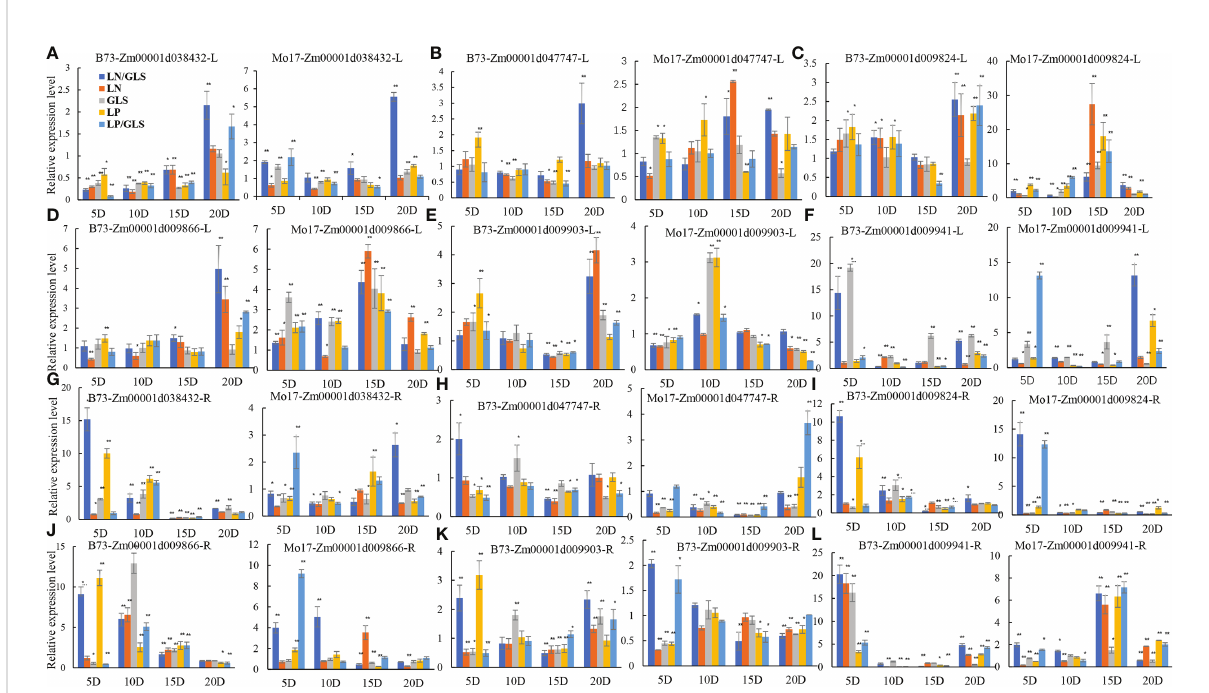
FIGURE 3 Expression patterns of six candidate genes in B73 and Mo17 under different treatments. (A, G) expression of Zm00001d038432 in root and leaf of B73 and Mo17. (B, H) expression of Zm00001d047747 in root and leaf of B73 and Mo17. (C, I) expression of Zm00001d009824 in root and leaf of B73 and Mo17. (D, J) expression of Zm00001d009866 in root and leaf of B73 and Mo17. (E, K) expression of Zm00001d009903 in root and leaf of B73 and Mo17. (F, L) expression of Zm00001d009941 in root and leaf of B73 and Mo17. R, Root; L, Leaf; GLS, Gray spot treatment; LN, Low nitrogen treatment; LP, Low phosphorus treatment; LN/GLS, Simultaneous treatment of low nitrogen and gray spot disease; LP/GLS, Simultaneous treatment of low phosphorus and gray spot disease. ** Expression that is exceedingly signi fi cant; * expression that is signi fi